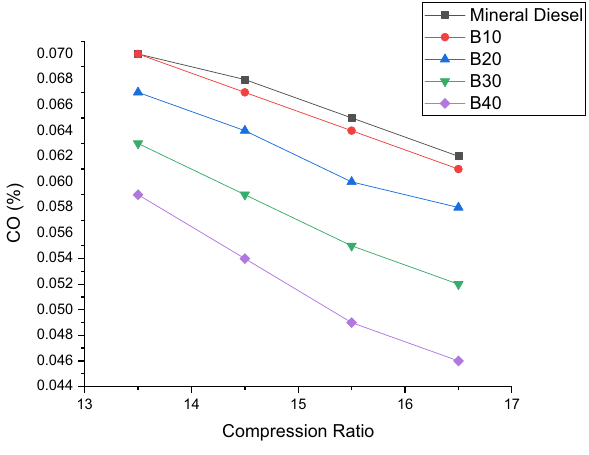
Fig. 10 Variation of carbon monoxide emissions of dual biodiesel sample blends at different compression